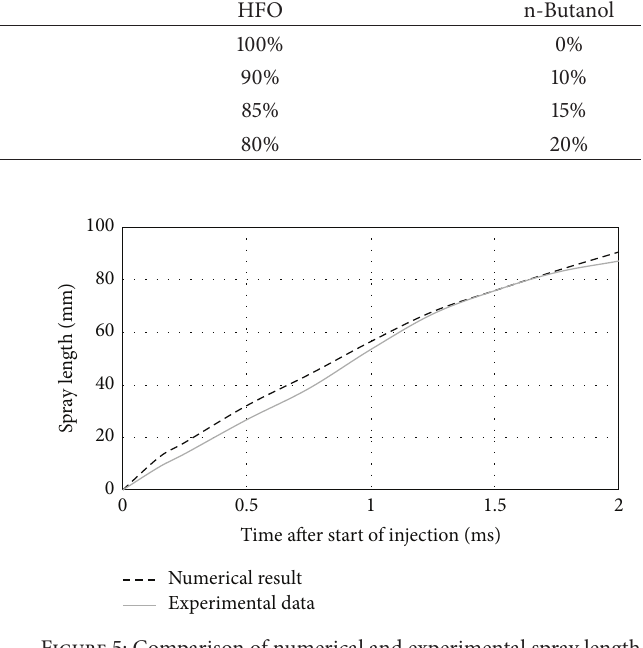
Figure 5: Comparison of numerical and experimental spray length of HFO at injection pressure of 600 bar [23].